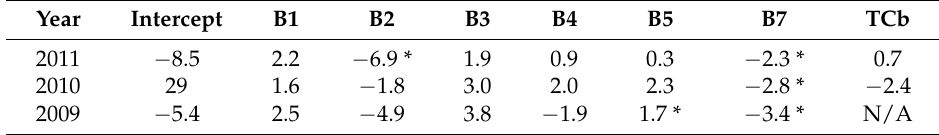
Table 3. Estimators of the regression models for coverage grass canopy (CGC).